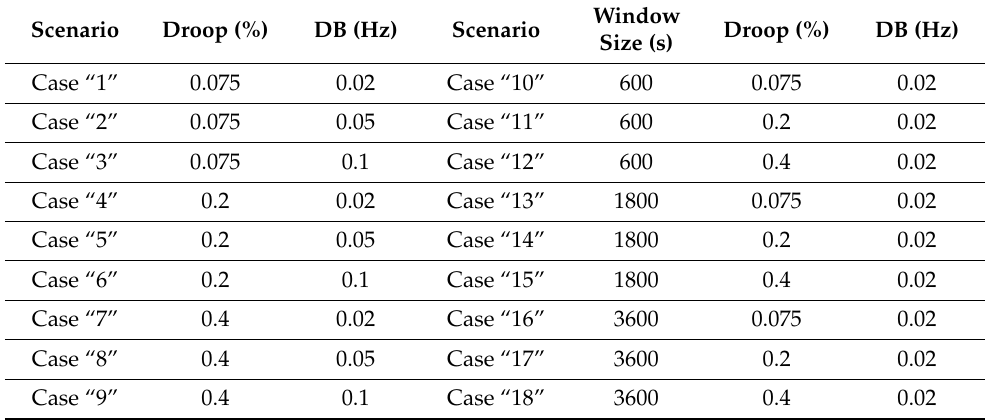
Table 1. A summary of the simulations without SOC restoration.